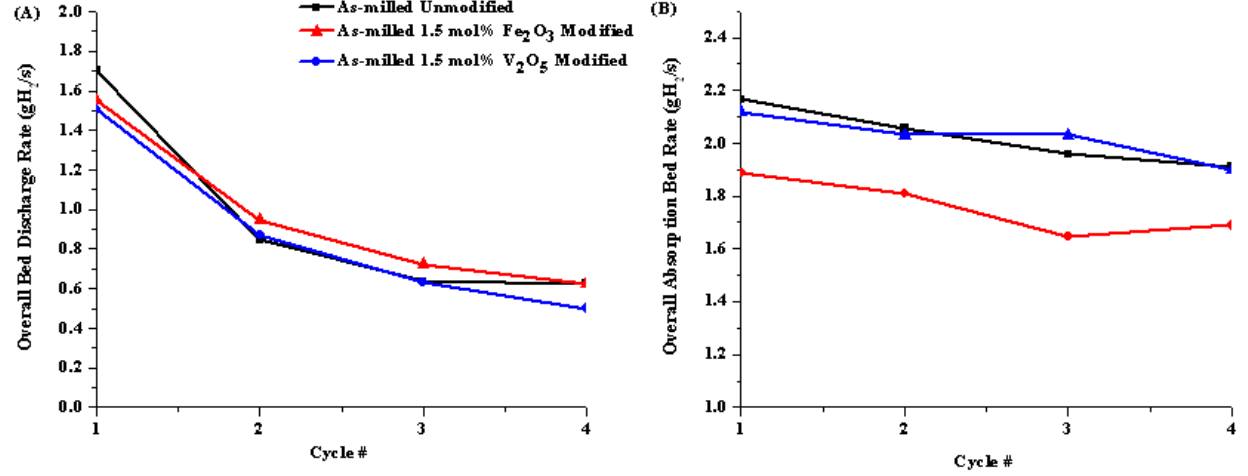
Figure 12. Bed discharge rate for unmodified (black), Fe modified samples. The material was discharged under standard